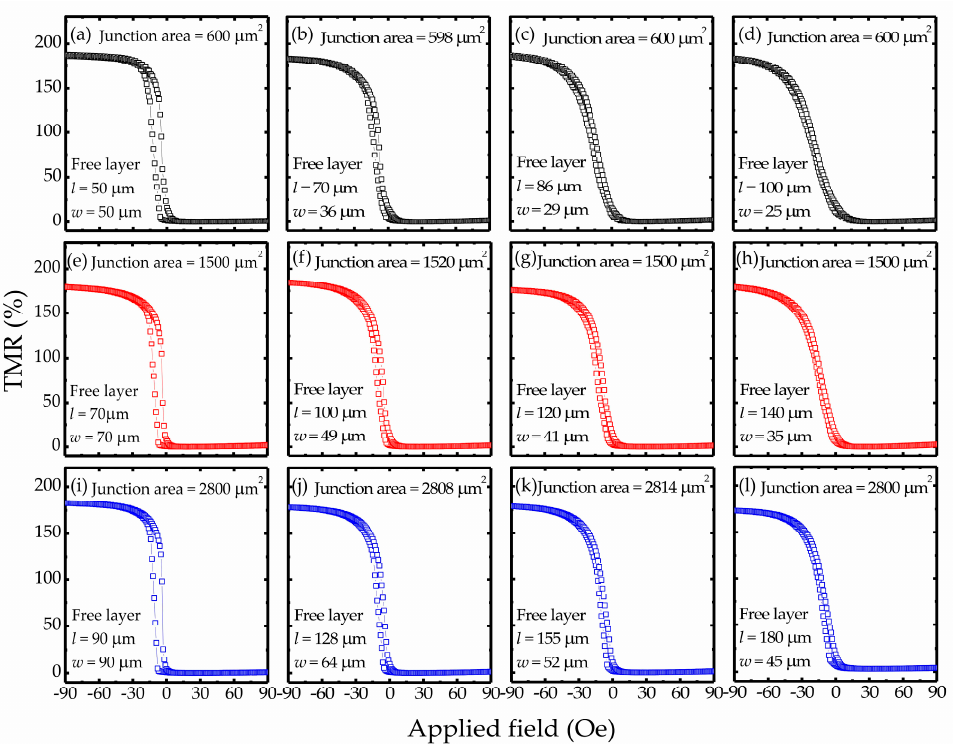
Figure 3. Magnetoresistance transfer curves for MTJ sensor Series A ( a )–( d ), B ( e )–( h ), and C ( i )–( l ) at a bias voltage of 100 mV and zero magnetic field. The aspect ratios of the free layer electrodes ranged from 1 to 4.